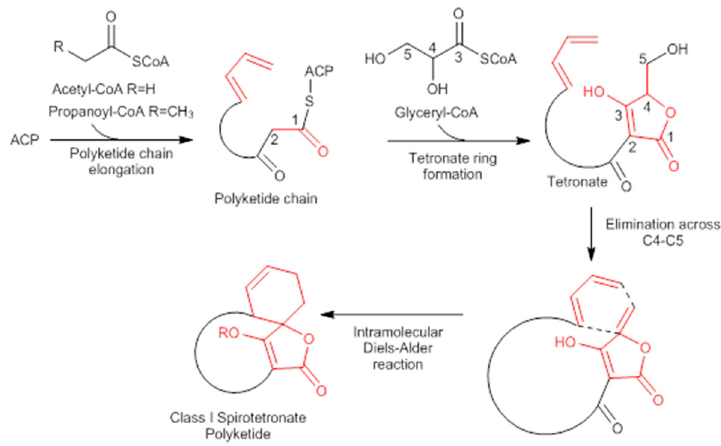
Figure 9. Incorporation of 13 C-labelled precursors into the polyketide backbone of abyssomicin C (modified from [73]).